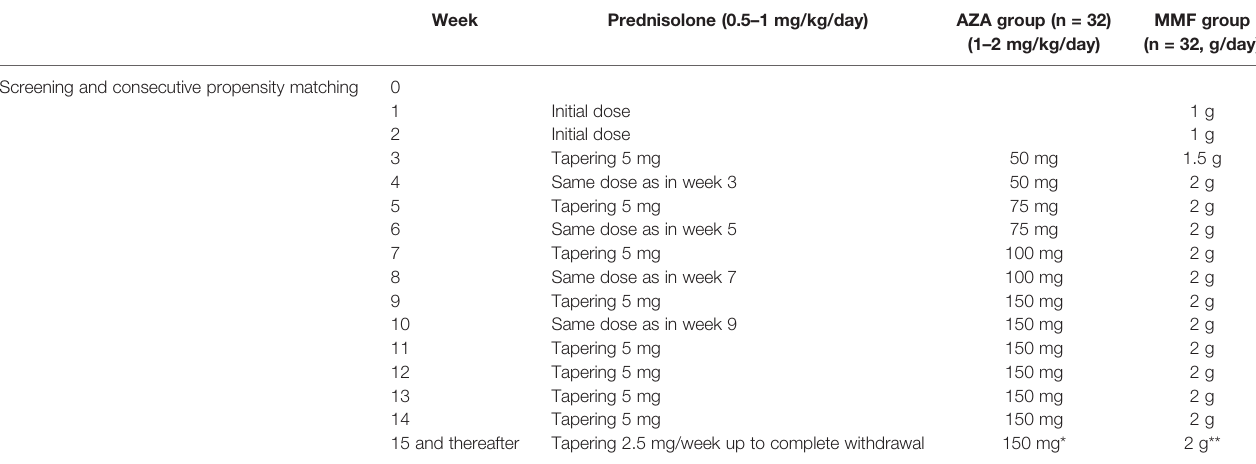
TABLE 1 | The treatment protocol in the two groups of the study. Week Prednisolone (0.5 – 1 mg/kg/day) AZA group (n = 32)